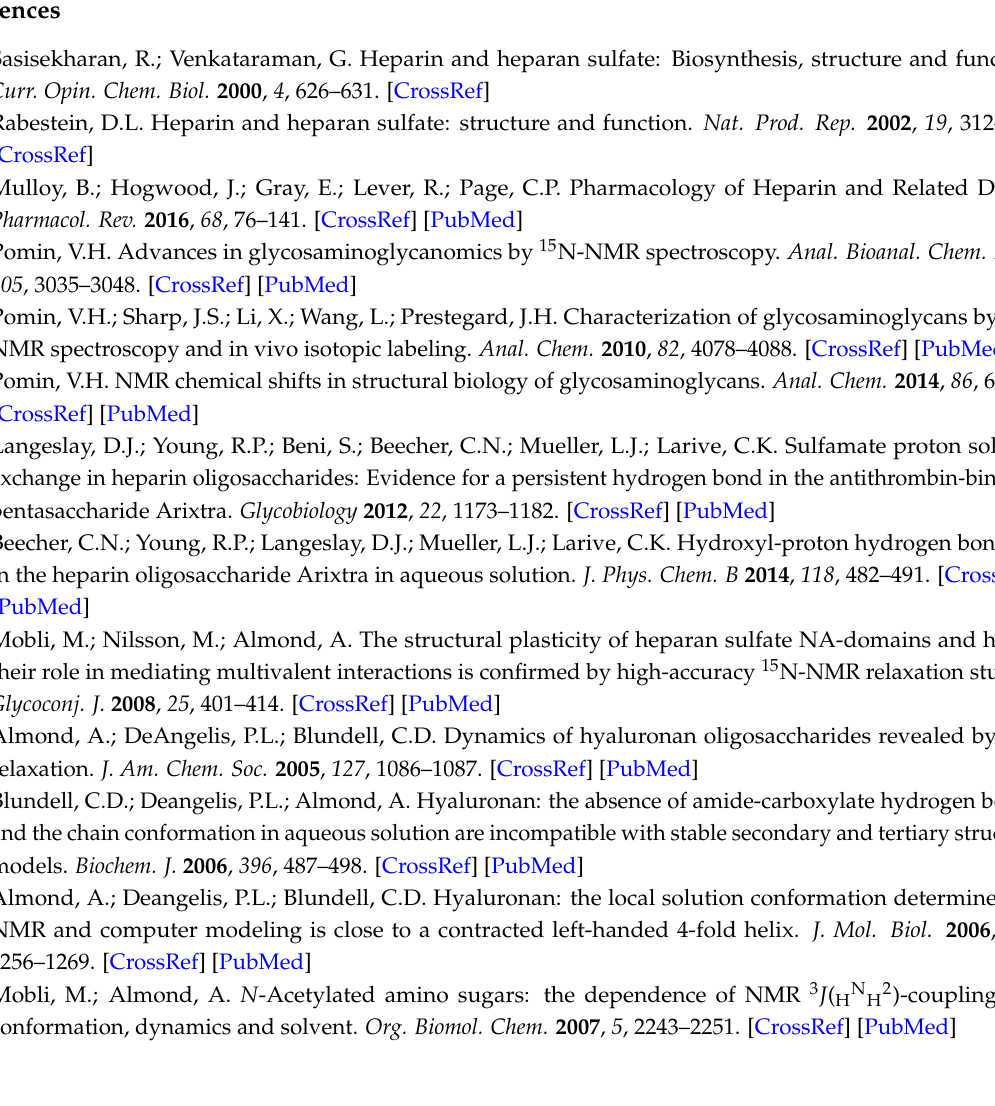
Figure S1: 2D NMR 1 H- 1 H TOCSY (A) and 1 H- 13 C HSQC (B) spectra of N -sulfo-glucosamine (GlcNS) (10